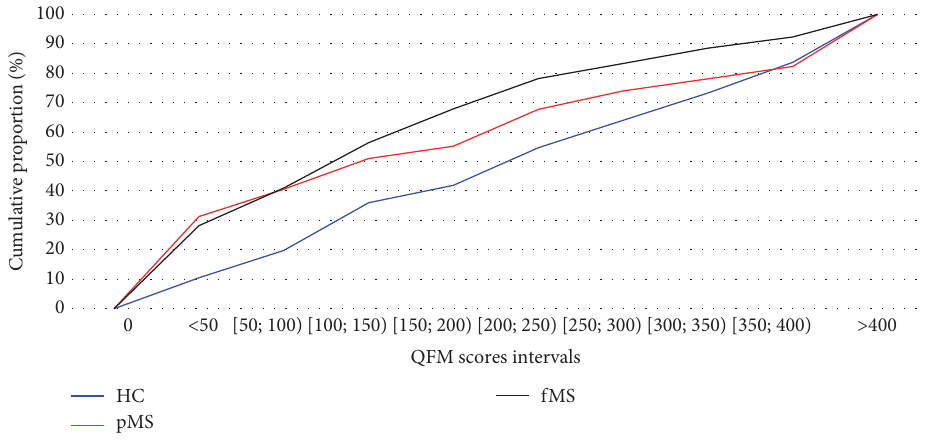
F IGURE 2: The cumulative distribution function of the QFM scores for each